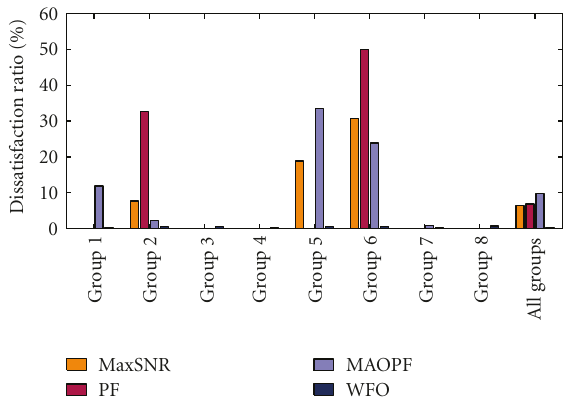
Figure 17: Mobile dissatisfaction when PDOR target = 10%.